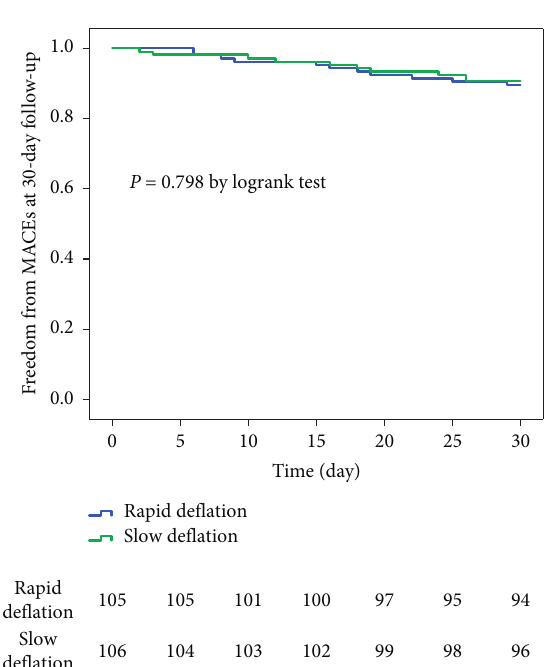
Figure 3: Kaplan–Meier curves of freedom from the occurrence of major adverse cardiovascular events (MACEs) for different balloon deflation strategy during 30-day